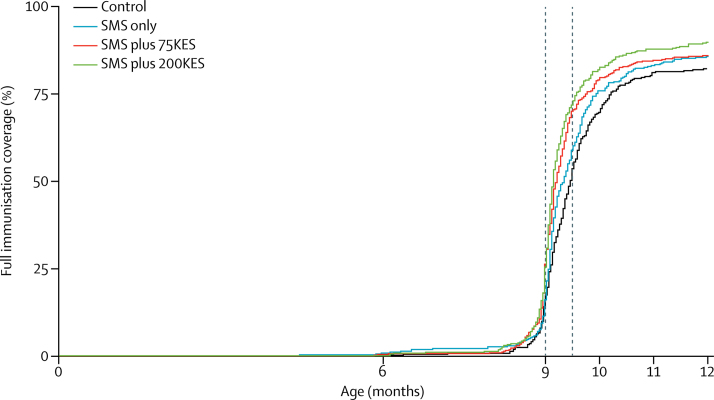
Effect of interventions on time to immunisationSMS=short message service. KES=Kenyan Shilling.